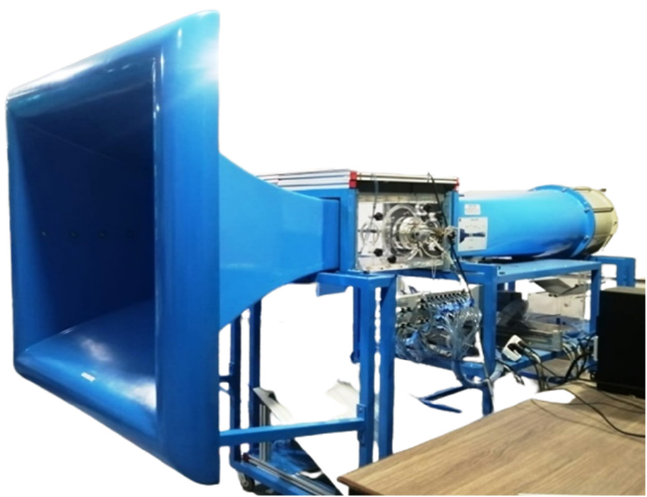
Figure 15. Experimental testing performed at a wind tunnel.